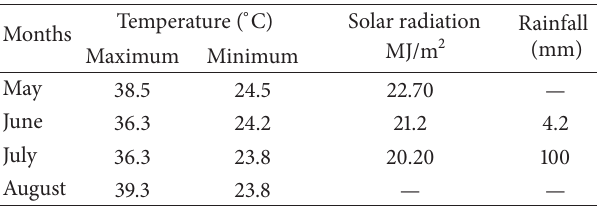
Table 1: The average temperature, solar radiation, and rainfall of the experimental site during the period of the experiment